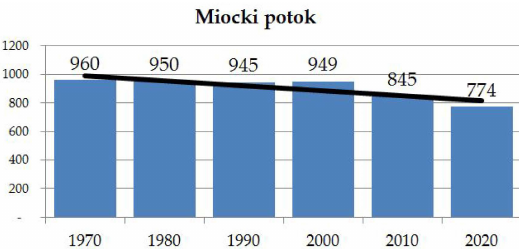
Figure 8. Demographic changes in the River Basin of Miocki Potok, Bijelo Polje Region,